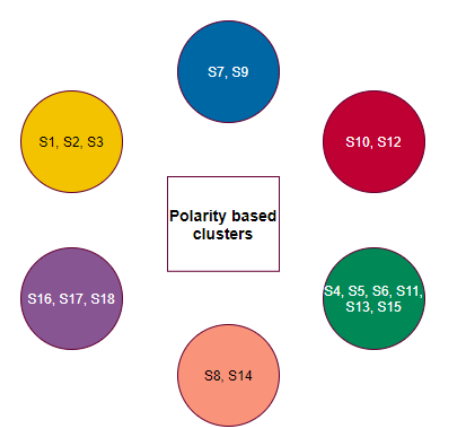
Figure 12. Clusters based on groups of species based on domain-wise polarity.